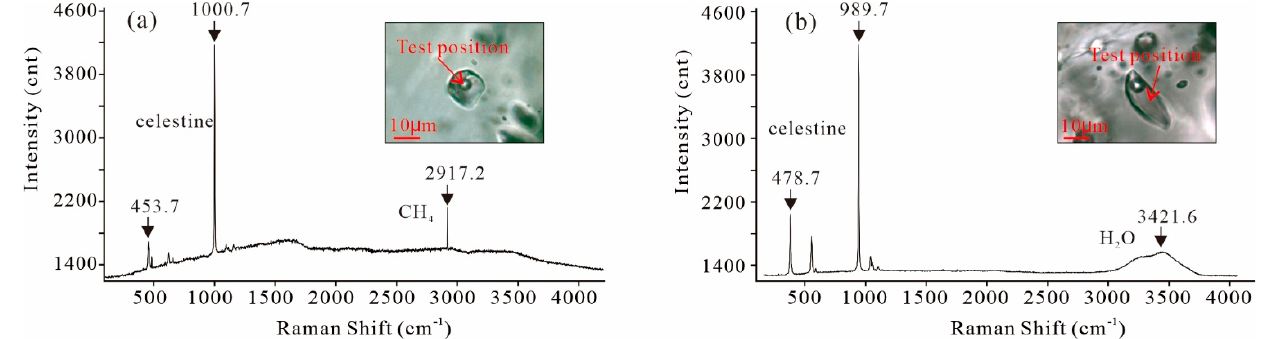
Figure 10. Representative Laser Raman spectra for fluid inclusions from the celestine deposit in the Xishan anticline. ( a ) vapor phase composition of fluid inclusion. ( b ) liquid phase composition of fluid inclusion.